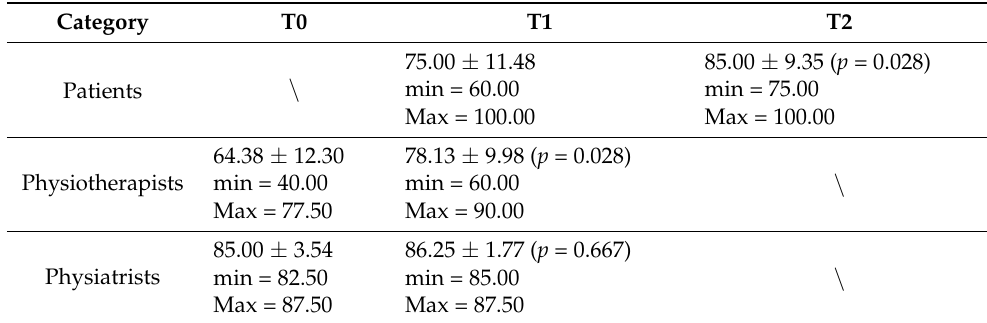
Table 4. SUS results for groups of